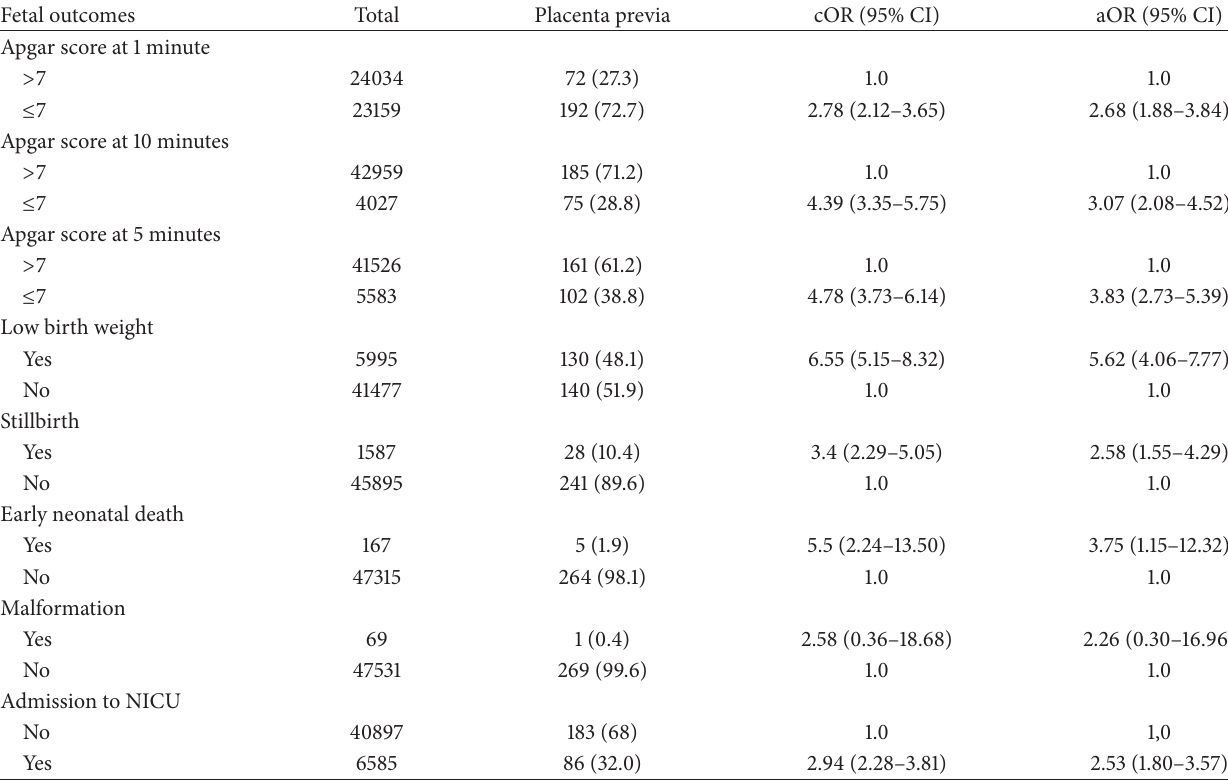
Table 4: Logistic regression for fetal outcomes associated with placenta previa ( 𝑁 = 47